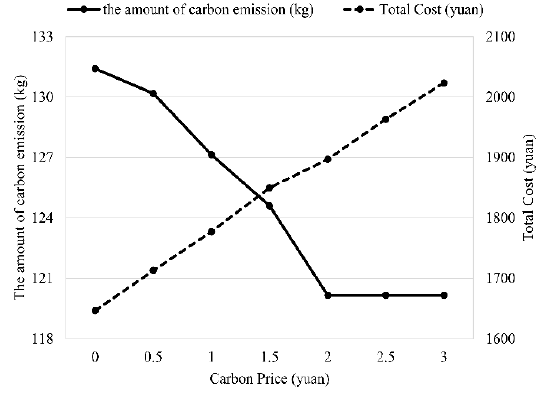
Fig. 4. Changes in carbon emissions and total costs under different carbon prices